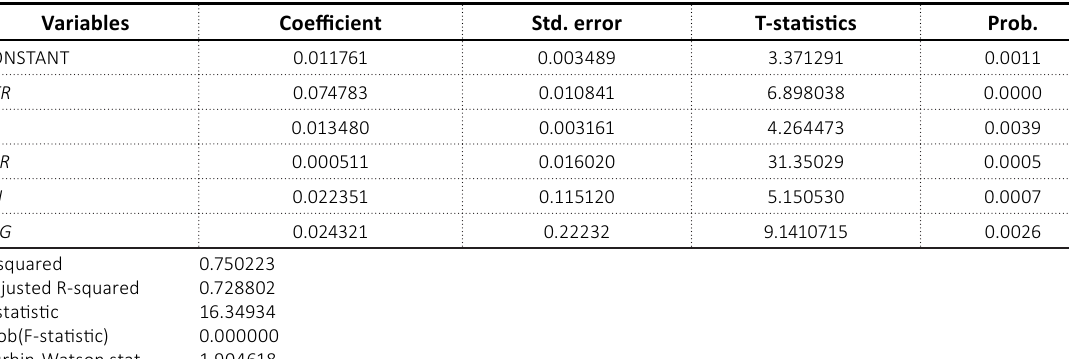
Table 2. Results of the empirical model analysis using a regression